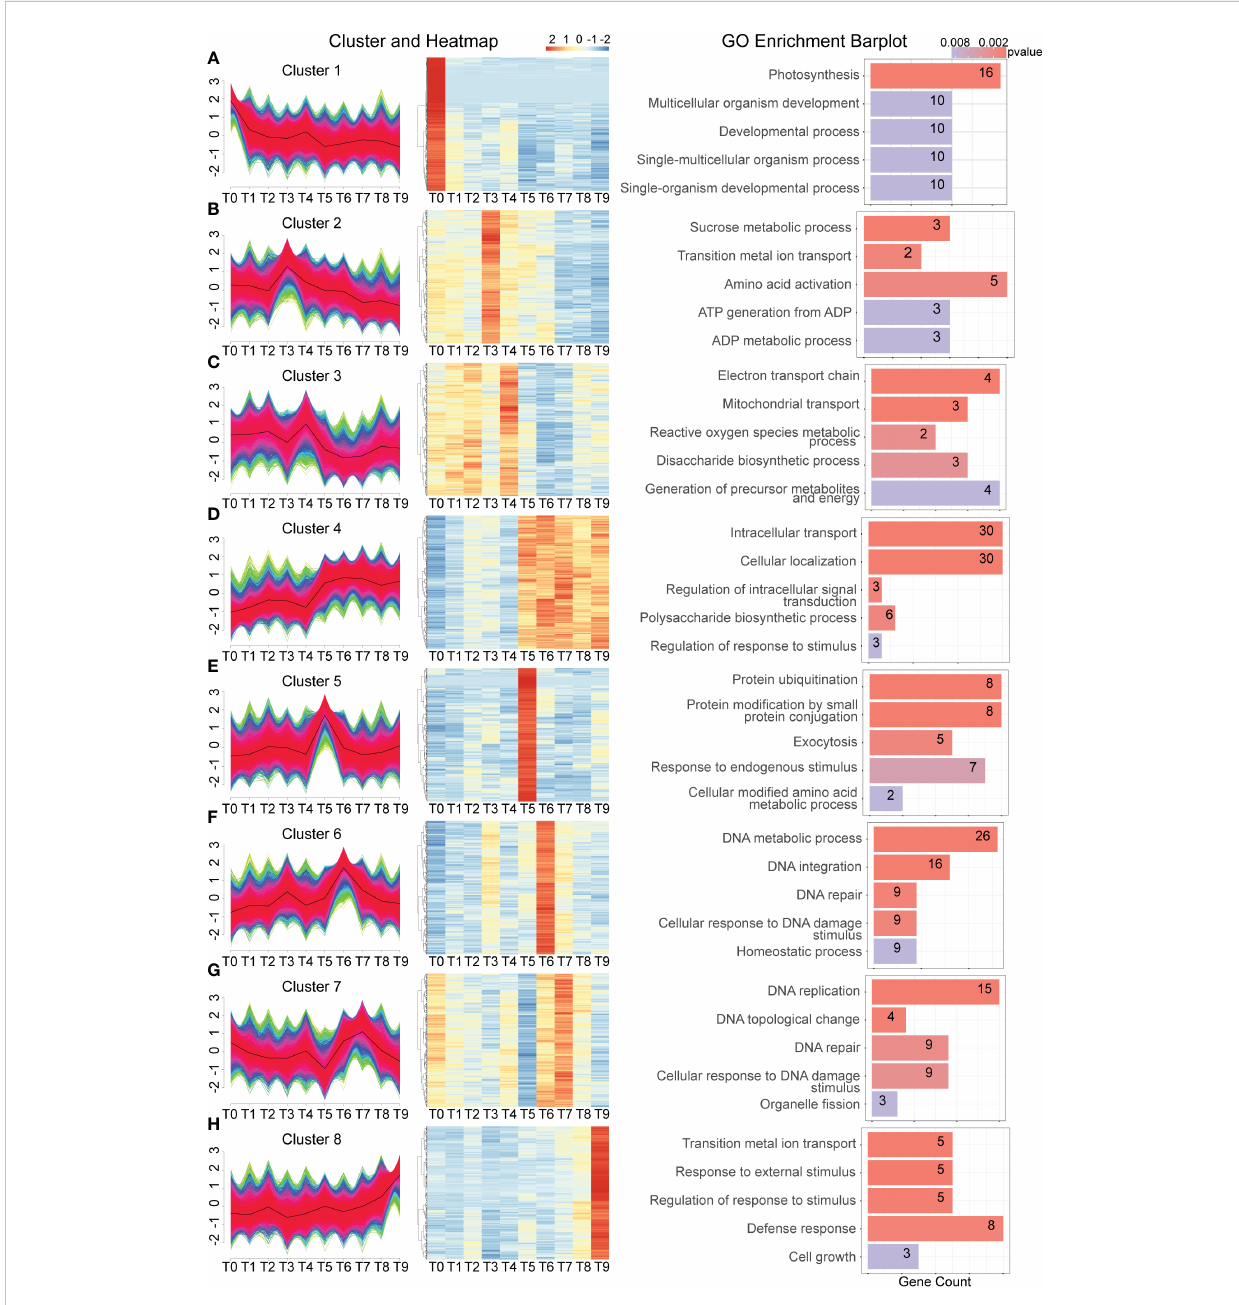
FIGURE 4 Time-course analysis of dynamic gene expression changes during Cd treatment. (A – H) . From left to right, gene expression is divided into 8 signi fi cant clusters based on the similarity of gene expression in each sample. The right side is a heat map of the expression of the top 1,000 genes most relevant to each cluster in each sample, graphically showing the top 5 signi fi cant GO